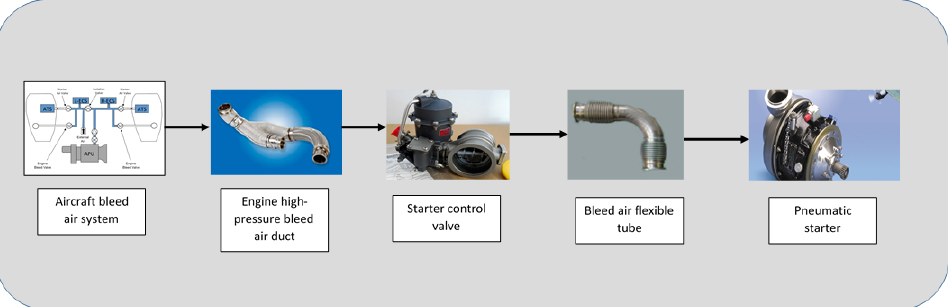
Figure 2. Engine bleed air and starting system